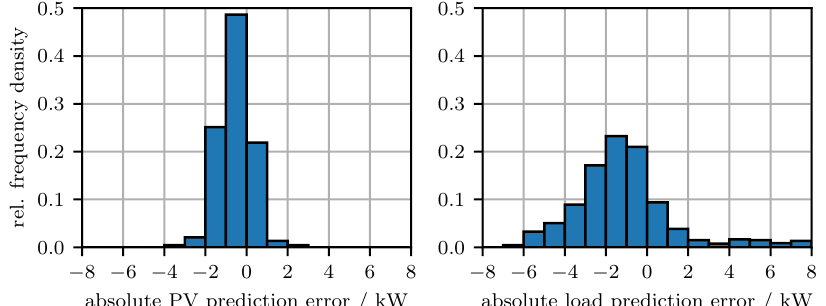
Figure 10. Relative frequency density of the prediction errors for the PV power forecast and the power demand forecast compared to simulation data (retrieved from historic measurement data) in the production facility in Scenario 2.